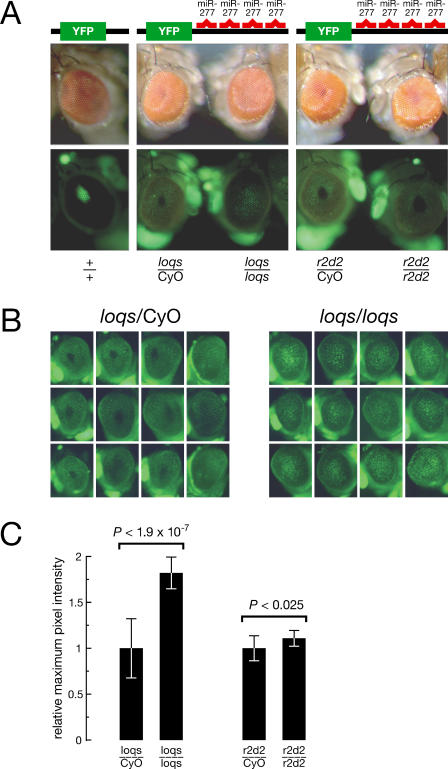
Silencing of a miRNA-Responsive YFP Reporter Requires loqs but Not r2d2
(A) A YFP transgene expressed from the Pax6-promoter showed strong fluorescence in the eye and weaker fluorescence in the antennae. Due to the underlying normal red eye pigment, the YFP fluorescence was observed in only those ommatidia that are aligned with the optical axis of the stereomicroscope. In heterozygous loqs
f00791/CyO flies bearing a miR-277-responsive, Pax6-promotor-driven, YFP transgene, YFP fluorescence was visible in the antennae but was repressed in the eye. In contrast, in homozygous mutant loqs
f00791 flies, YFP fluorescence was readily detected in the eye. A strong mutation in r2d2 did not comparably alter repression of the miR-277-regulated YFP reporter. The exposure time for the unregulated YFP reporter strain was one-fourth that used for the miR-277-responsive YFP strain. The exposure times were identical for the heterozygous and homozygous loqs and r2d2 flies.(B) Additional images of eyes from loqs
f00791 heterozygous and homozygous flies bearing the miR-277-responsive YFP reporter transgene diagrammed in (A).(C) Quantification of fluorescence of the miR-277-responsive YFP transgene in eyes heterozygous or homozygous for loqs or r2d2. The maximum pixel intensity was measured for each eye (excluding antennae and other tissues where miR-277 does not appear to function). The graph displays the average (n = 13) maximum pixel intensity ± standard deviation for each homozygous genotype, normalized to the average value for the corresponding heterozygotes. Statistical significance was estimated using a two-sample Student's t-test assuming unequal variance.The images in (A) were acquired using a sensitive, GFP long-pass filter set that transmits yellow and red autofluorescence. Images in (B) and for quantitative analysis were acquired using a YFP-specific band-pass filter set that reduced the autofluorescence recorded.